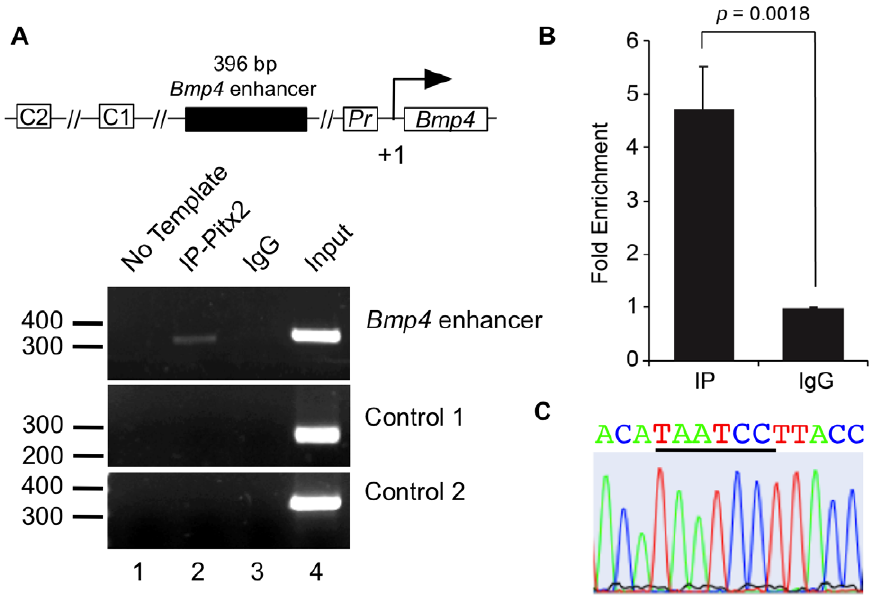
Figure 6. Pitx binds the minimal Bmp4 enhancer invivo . ( A ) Schematic representation of the ChIP assay design. The 396-bp Bmp4 CRM containing the Pitx1/2 binding site is shown along with two control regions, C1 and C2. C1 and C2 are located upstream of the Bmp4 transcription start site and do not contain Pitx1/2 binding sites (see Materials and Methods). The transcriptional start site (TSS) is marked as + 1 and Pr is the Bmp4 proximal promoter. Chromatin Immunoprecipitation (ChIP) assays were performed in LS-8 cells. Lane 1 is a no template control using the test primers, lane 2 is the Pitx2 antibody immunoprecipitated (IP-Pitx2) chromatin, lane 3 is the normal rabbit immunoglobulin G (IgG) immunoprecipitated chromatin, and lane 4 is the input chromatin amplified using the test primers. The top gel ( Bmp4 enhancer) represents the test primers encompassing Pitx1/2 motif in the 396-bp Bmp4 CRM. Lane 2 exhibits a 338 amplicon of the expected size. The lower two gels reveal the absence of amplicon products from the two control regions C1 and C2. An amplicon from these regions are only detected in the input control groups. ( B ) Quantitative real-time PCR was performed using the same conditions for the ChIP assays as described in (A). The 4.7-fold enrichment of the region containing the 396-bp Bmp4 CRM in the Pitx2 antibody immunoprecipitated (Pitx2-IP) chromatin is shown in the bar graph. Significance is denoted by p =0.0018 for the enrichment of amplified product in Pitx2-IP versus an IgG control set at 1.0. ( C ) Sequencing analysis demonstrates the presence of a Pitx1/2 binding site in the product amplified using the Bmp4 minimal CRM region-specific primers and Pitx2-IP chromatin as